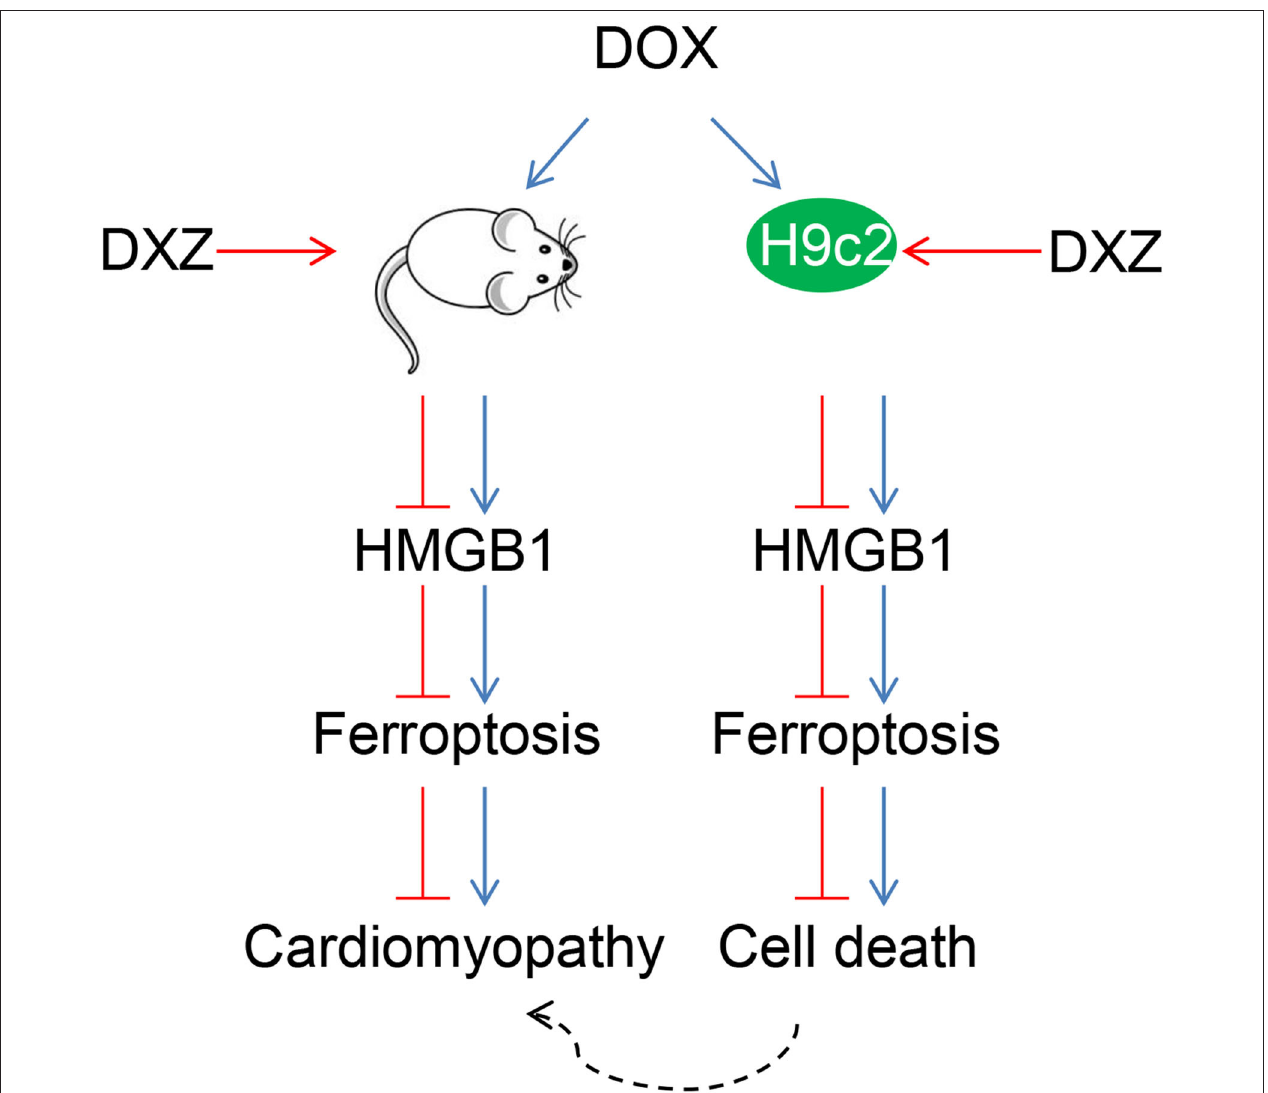
FIGURE 9 | Protective effects of DXZ on DOX-induced rat cardiomyopathy through regulating HMGB1. A brief description of the mechanisms involved in this study that DXZ targeting HMGB1 inhibited ferroptosis of H9c2 cells and alleviated DOX-induced heart failure in